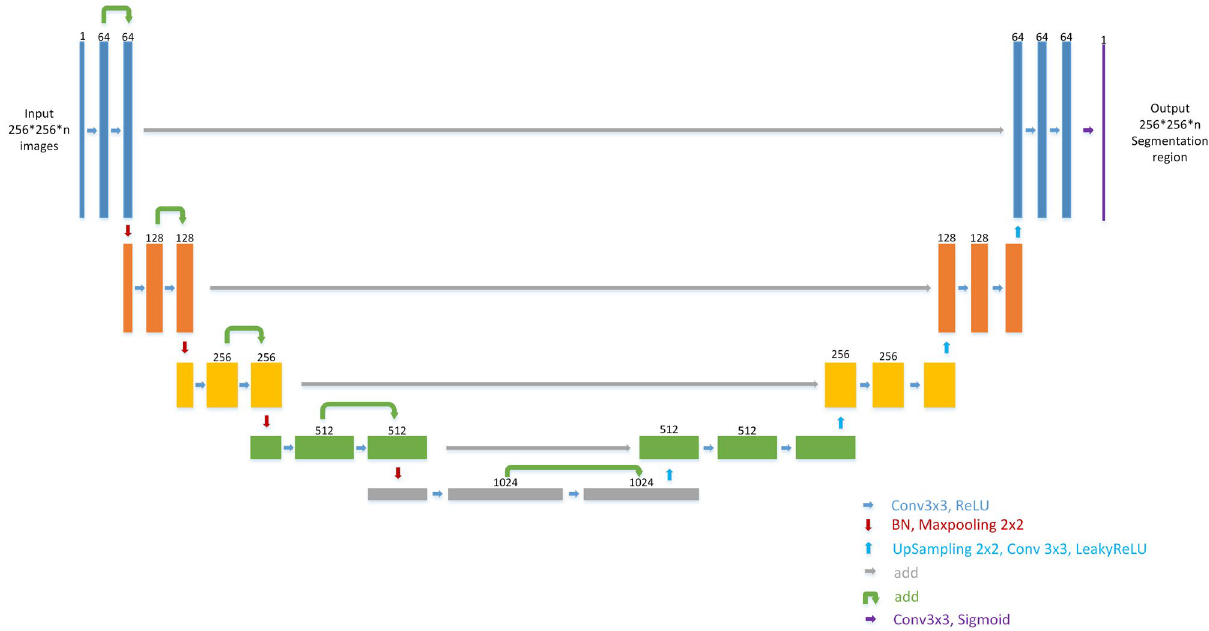
Figure 5. Res U-net architecture. This net is used to do the ROI segmentation with CT image to get the position of pulmonary. Each box corresponds to a multi-channel feature map. The number of channel shown on top of the box. The bottom right corner shows the meaning of the